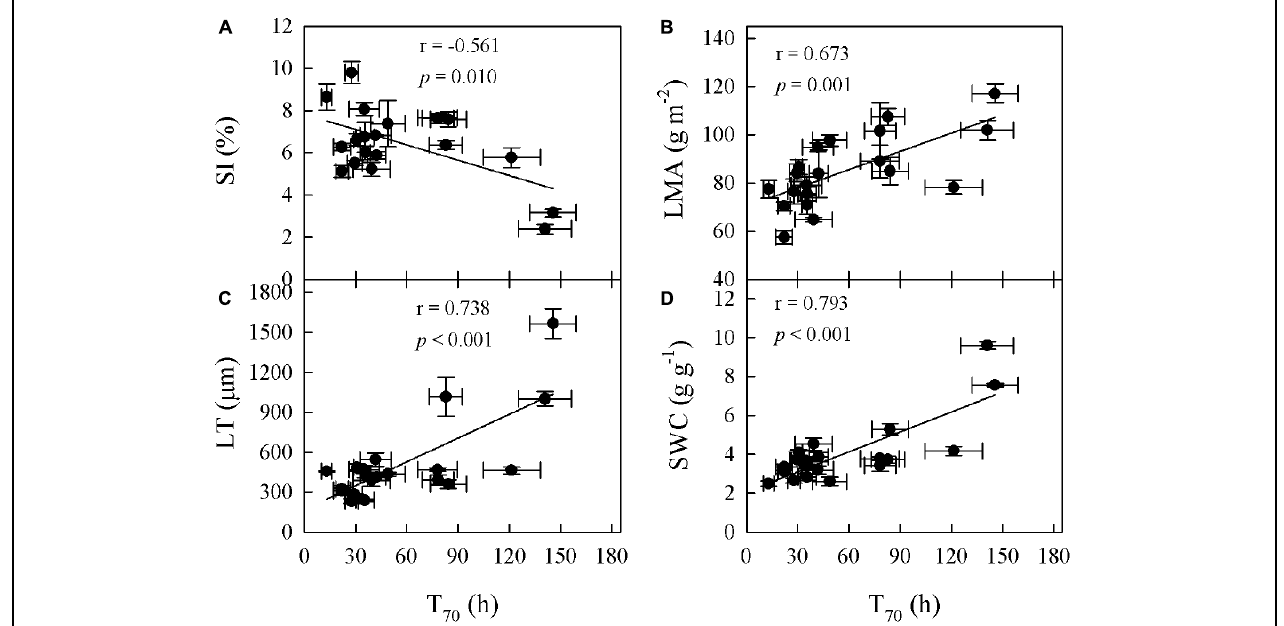
FIGURE 3 | Cross-species correlations between time required for drying of saturated leaves to 70% RWC (T 70 ) and stomatal index (SI; A), leaf thickness (LT; C), leaf mass per unit area (LMA; B), and saturated water content (SWC; D) in Cymbidium .